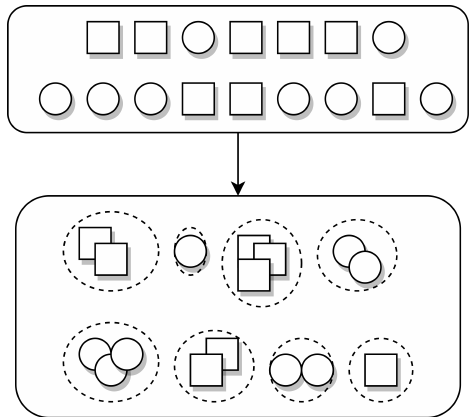
Figure 4. Illustration of intracluster loss.